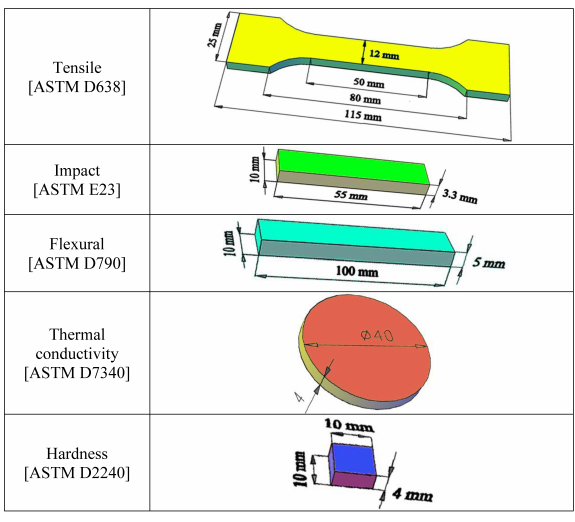
Fig. 3. Samples’ dimensions of tensile, impact, flexural, thermal conductivity, and hardness tests.